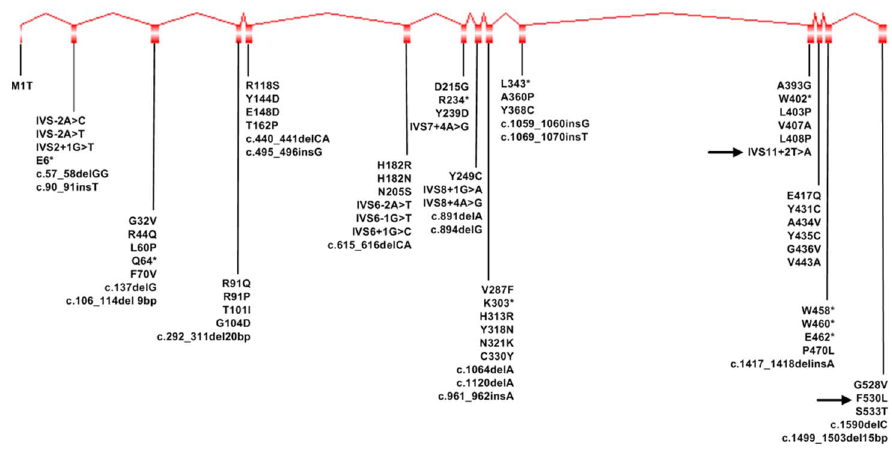
Figure 1. LCA related mutations in RPE65 gene. The black arrow indicates the novel mutation discovered in this study.